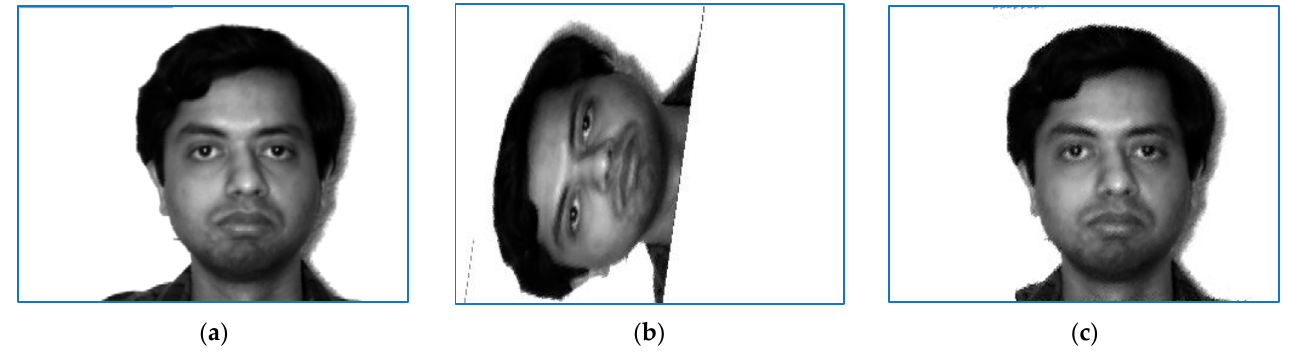
Figure 1. Images of subject 10: ( a ) target image, ( b ) sensed image, and ( c ) correctly restored image.